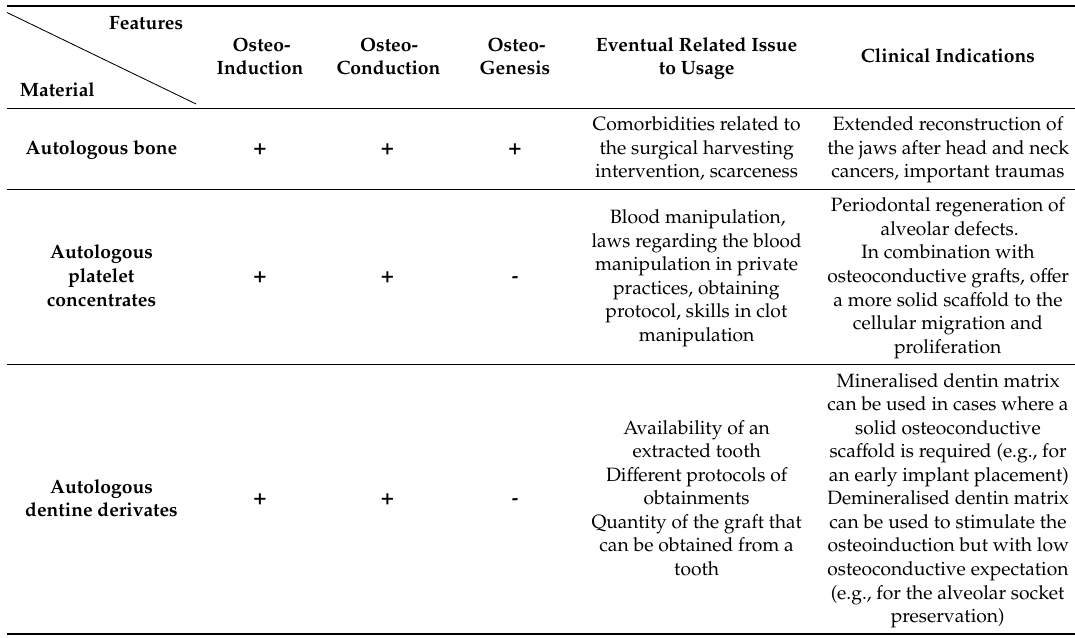
Table 1. Table resuming the autologous biomaterial, their properties regarding the bone regeneration, the problem related to their use, and eventual clinical